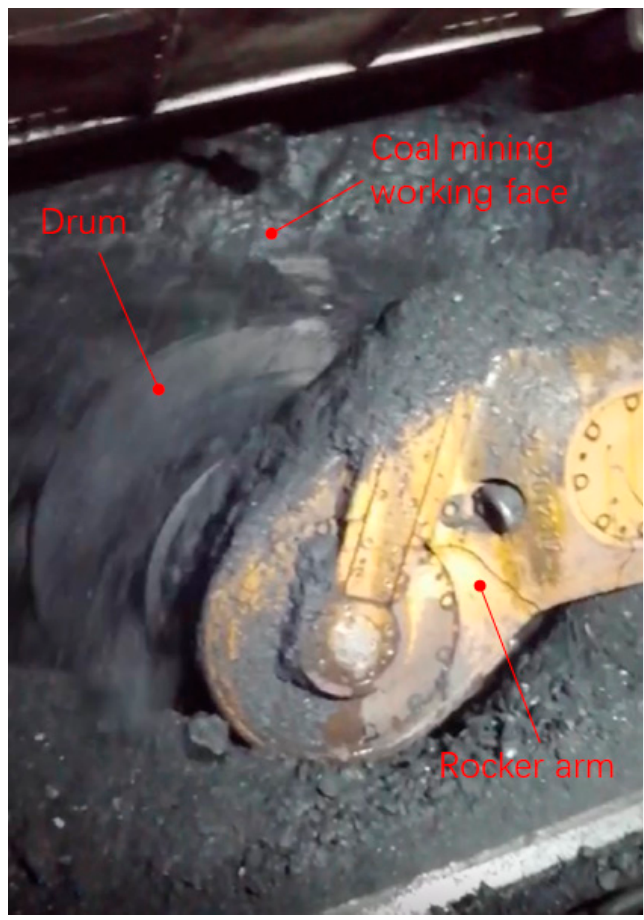
Figure 7. Testing ground.